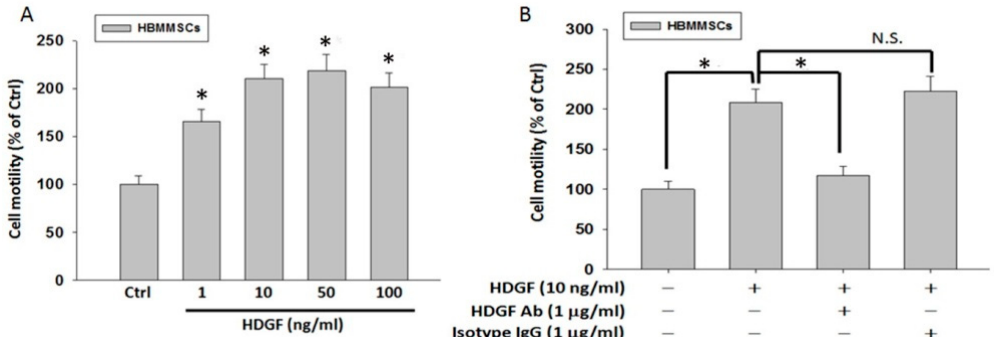
Figure 6. ( A ) HDGF induces HBMSCs motility at various concentrations. HBMMSCs were treated with HDGF (1, 10, 50, 100 ng/ml) for 24h. The effect of HDGF on motility capacity of HBMMSCs was measured by motility assay. ( B ) HDGF neutralizing antibody inhibits HDGF-mediated HBMMSCs recruitment. HBMMSCs treated with HDGF neutralizing antibody (HDGF-NAb; 1 µ g/ml) in the presence or absence of HDGF (10 ng/ml) were analyzed for the inhibitory effect of HDGF-Nab on HDGF-mediated recruitment motility. * p < 0.01 versus control (line 1); * p < 0.01 versus only HDGF treatment (line 2) (mean ± SD, n = 3).